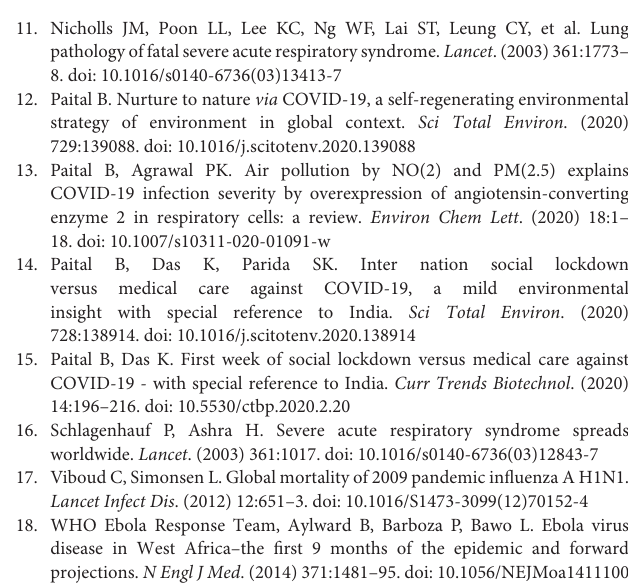
Supplementary Figure 3 | Death numbers and relations before apex day and total. Supplementary Figure 4 | Patterns of numbers of infected persons and peak day of investigated countries. Supplementary Table 1 | Days before and after apex day. Supplementary Table 2 | Calculation of the numbers of patients from the first wave. Supplementary Table 3 | Calculation of the numbers of deaths from the first wave. Supplementary Table 4 | Calculation of the numbers of patients from the entire pandemic. Supplementary Table 5 | Calculation of the numbers of deaths from the entire